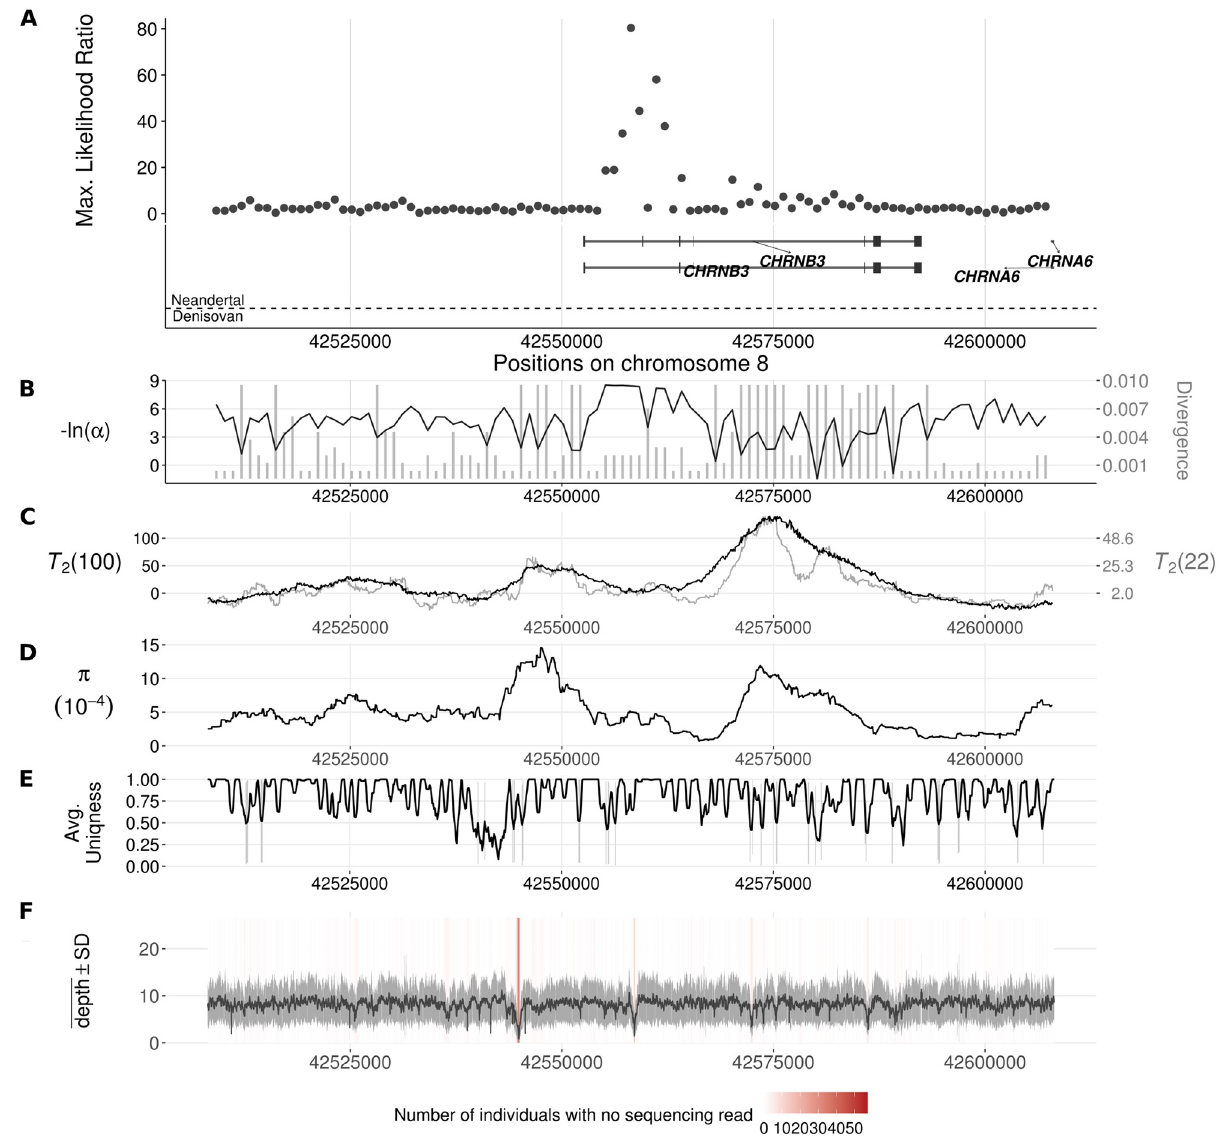
Fig 8. Introgression sweep signals, tracks of Neanderthal or Denisovan ancestry, parameter estimates, and sequencing properties across the 100 kb region on chromosome 8 covering the CHRNB3 gene in CEU. A . Likelihood ratio test statistic computed from Model 1 of VolcanoFinder on data on within-CEU polymorphism and substitutions with respect to chimpanzee. Horizontal light gray bars correspond to regions that were filtered based on mean CRG. Gene tracts and labels for key genes are depicted below the plot, with the wider bars representing exons. Tracks of putative regions with Neanderthal (above the horizontal line) or Denisovan (below the horizontal line) ancestry are located below gene diagrams. Higher probabilities of Neanderthal or Denisovan ancestry are depicted with darker colored bands (data from [22]). Non-synonymous mutations with Neanderthal are indicated in red. B . Values for α and divergence D corresponding to the maximum likelihood estimate of the data. Black line corresponds to − ln( α ) and vertical gray bars correspond to estimated D . C . Likelihood ratio test statistic computed from T 2 of BALLET on data on within-CEU polymorphism and substitutions with respect to chimpanzee using windows of 100 (black) or 22 (gray) informative sites on either side of the test site. D . Mean pairwise sequence difference ( ^ y ) computed in five kb windows centered on each polymorphic site. E . Mappability uniqueness scores for 35 nucleotide p sequences across the region. F . Mean sequencing depth across the 99 CEU individuals as a function of genomic position, with the gray ribbon indicating standard deviation. The background heatmap displays the number of individuals devoid of sequencing reads as a function of genomic position, with darker shades of red indicating a greater number of individuals with no sequencing reads.